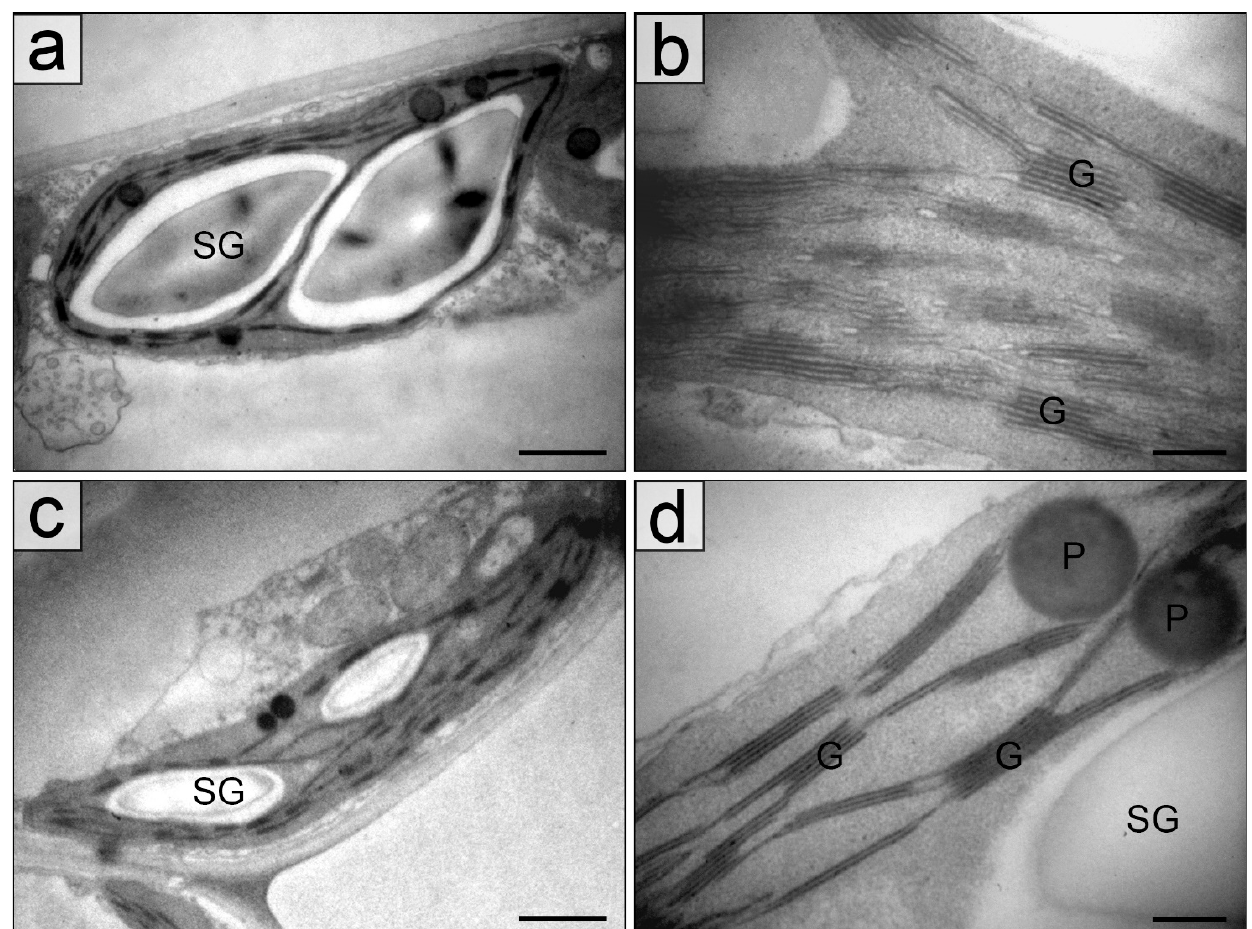
Figure 5. General view of chloroplasts with grana, starch grains and plastoglobules ( a , c ) and chloroplast fragments with grana consisting of different number of thylakoids ( b , d ) from palisade parenchyma cells of mature leaves of Hydrocharis morsus-ranae in the shade ( a , b ) and in the sun ( c , d ). Abbreviations: SG—starch grain, G—granum, Pl—plastoglobule. Scale bar: ( a , c )—1 µm, ( b , d )—0.2 nm.